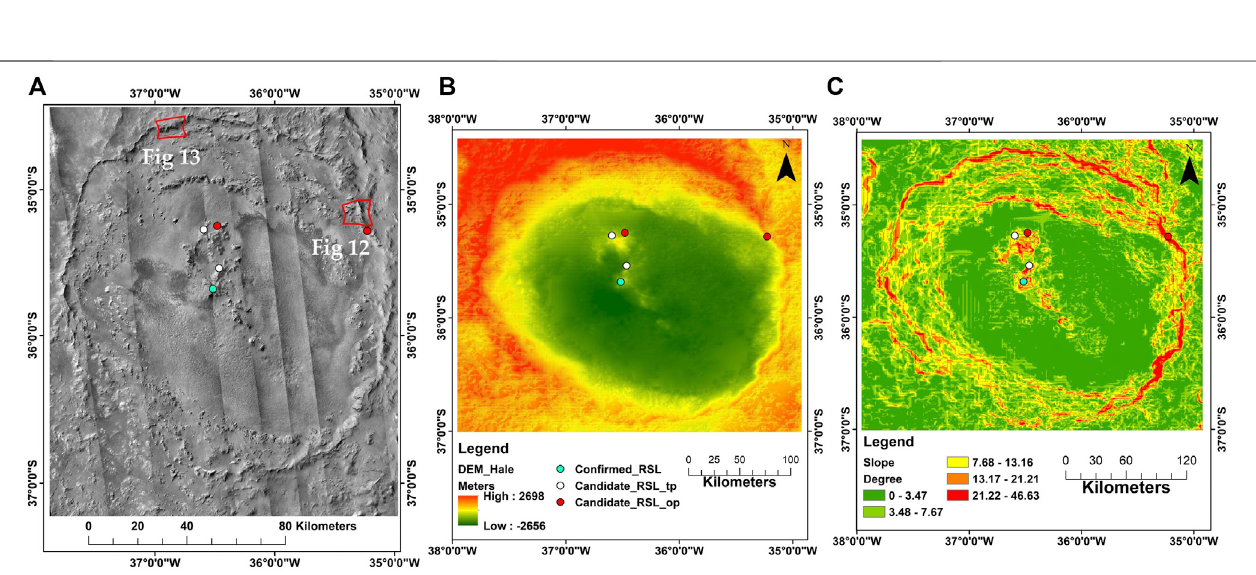
FIGURE 3 | Hale crater (A) CTX mosaic image, (B) MOLA DEM, (C) Slope map. Red polygons are footprint of CRISM data coverage in the scene.